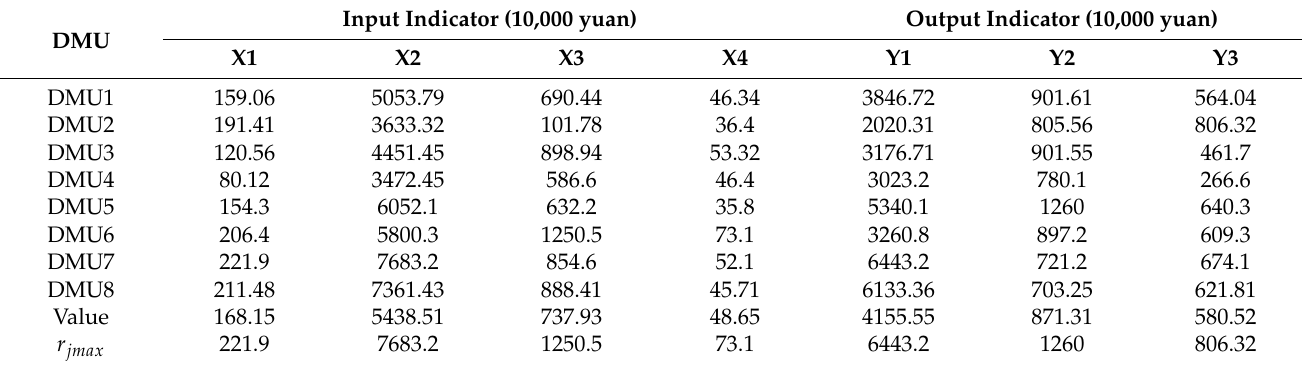
Table 4. The value of each indicator of the project